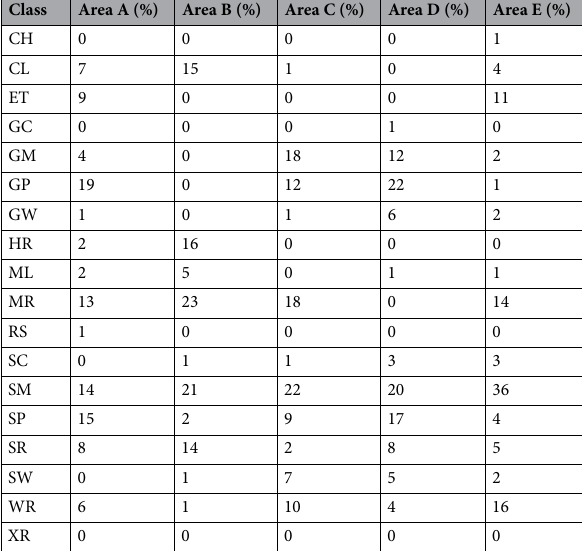
Table 2. Volume ratio of soil according to USCS.